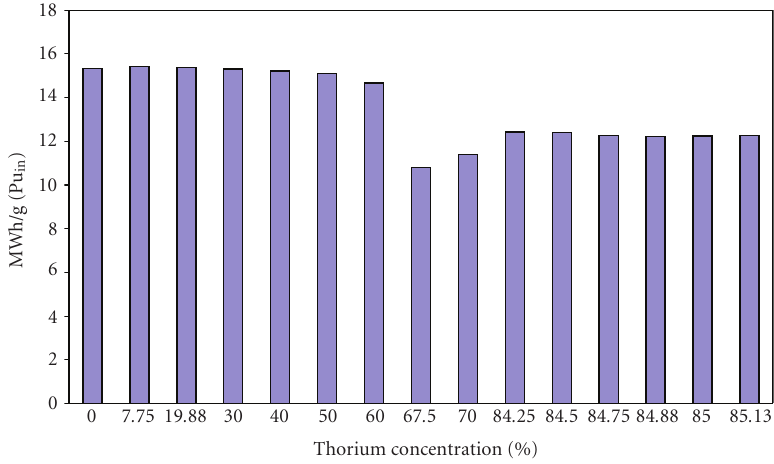
Figure 13: Energy produced per g Puin versus Th concentration.